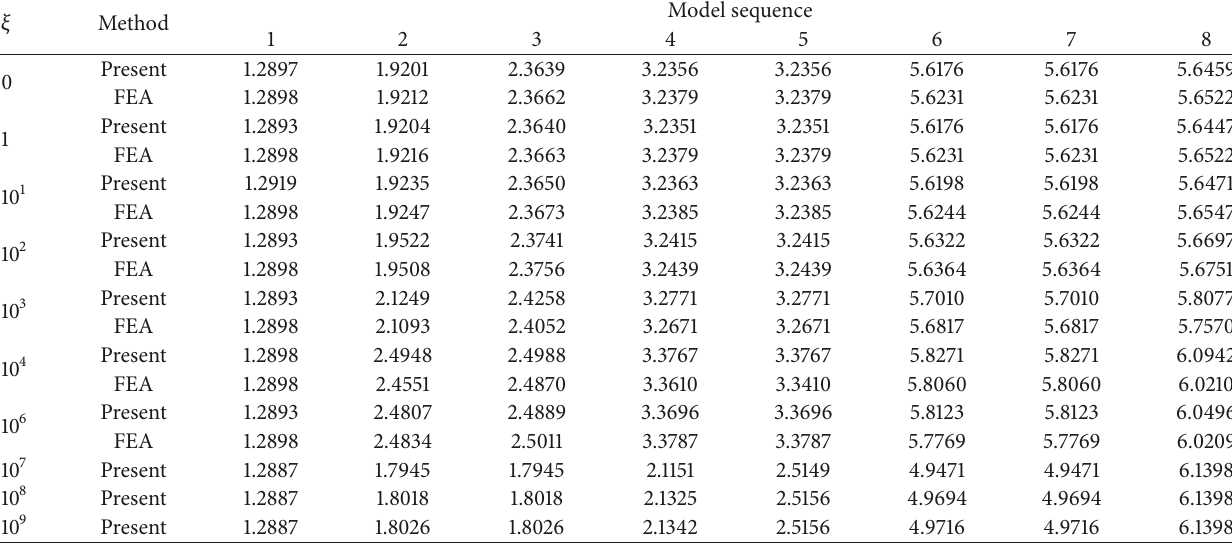
Table 1: Frequency parameters Ω = 𝜔𝑏 2 (𝜌ℎ/𝐷) 1/2 /𝜋 2 for the square plate of case 1 with restraining stiffness, 𝜉 𝑘 point support.